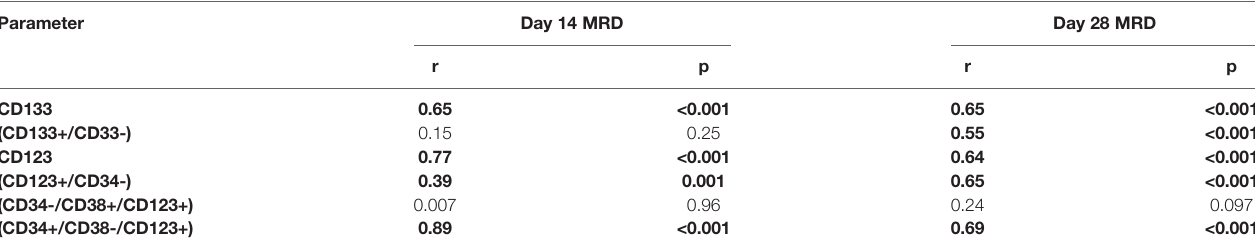
MRD, measurable/minimal residual disease. Bold denotes signi fi